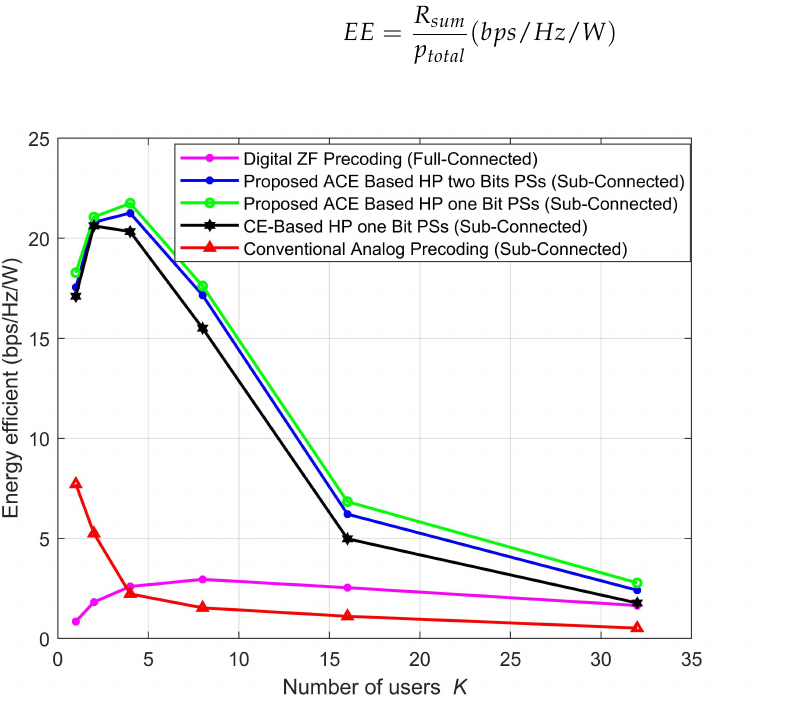
Figure 5. Energy efficiency of ACE-based method with sub-connected PSs (when C = A = 10), where SNR =